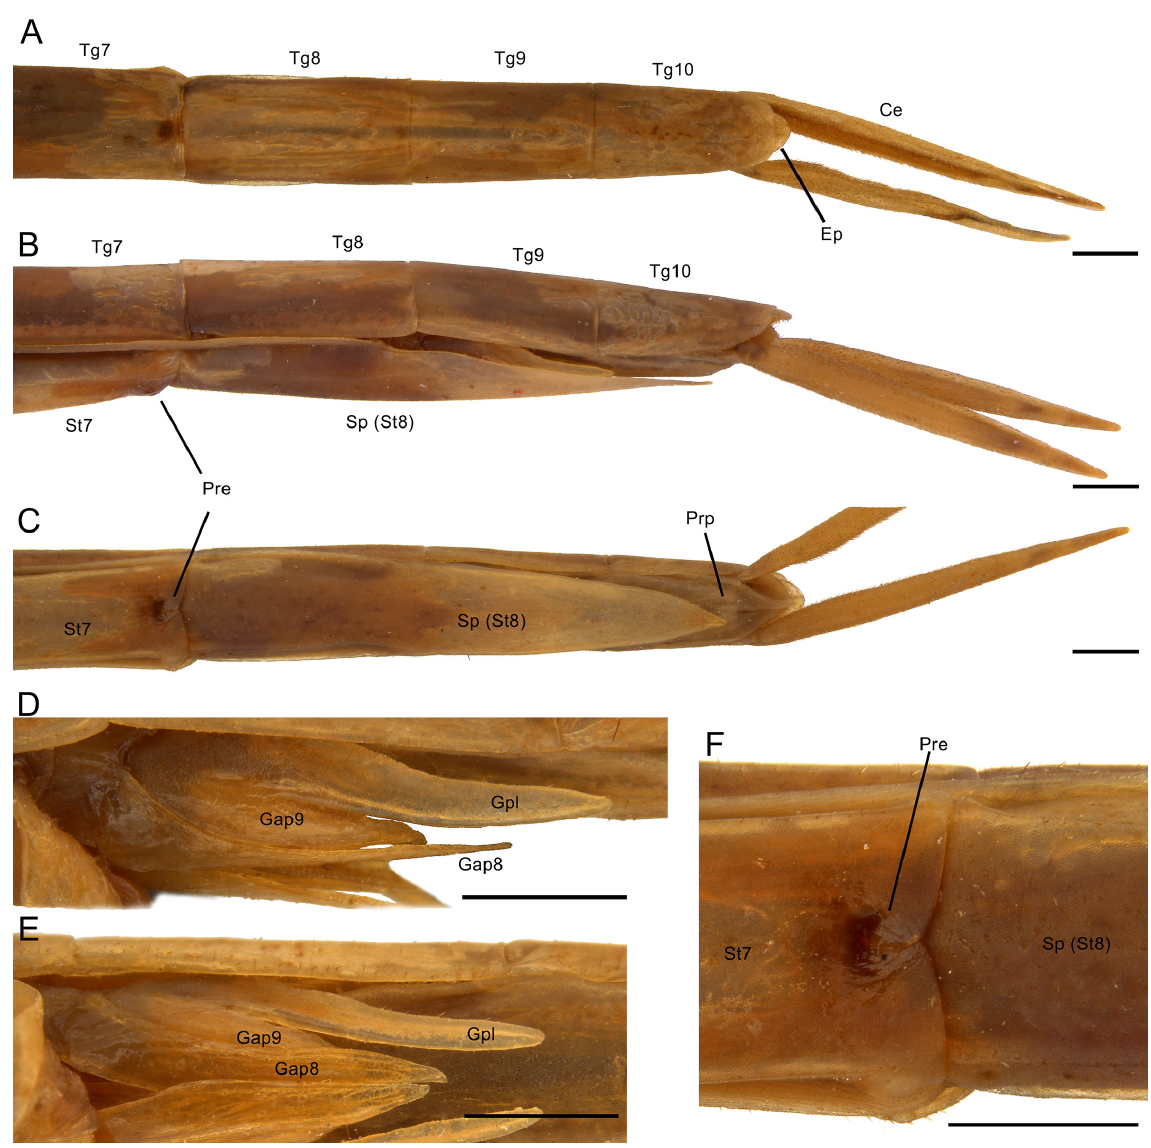
Fig. 28. Arumatia aramatia Ghirotto gen. et sp. nov., holotype, ♀ (MZUSP 1352), terminalia morphology. A . Dorsal view. B . Lateral view. C . Ventral view. D–E . Detail of external genitalia, lateral view (D), ventral view (E). F . Detail of praeopercular organ, ventral view. Abbreviations: Ce = cercus; Ep = epiproct; Gap = gonapophysis; Gpl = gonoplac; Pre = praeopercular organ; Prp = paraproct; Sp = subgenital plate; St = sternum; Tg = tergum. Scale bars: 1